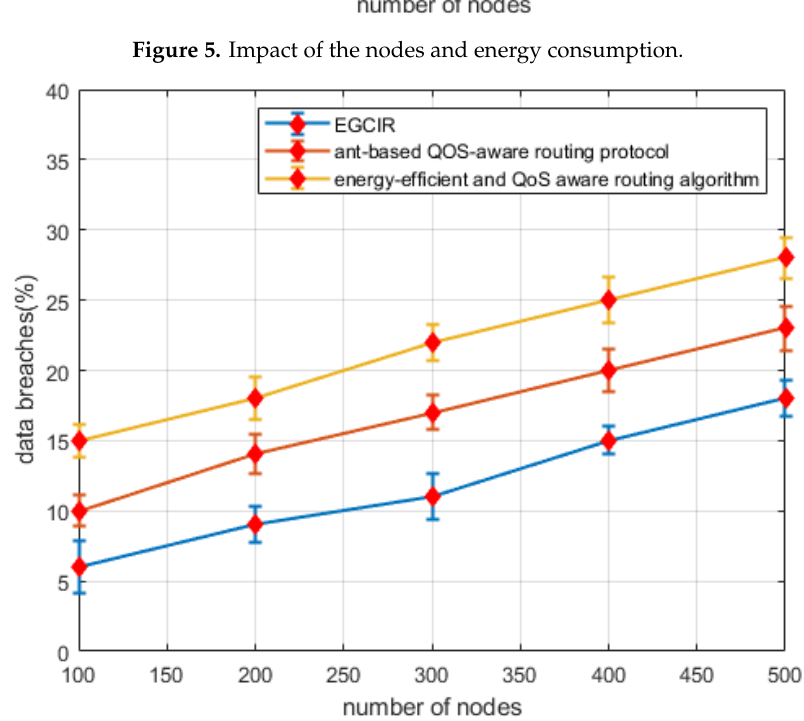
Figure 6. Impact of the nodes and data breaches.